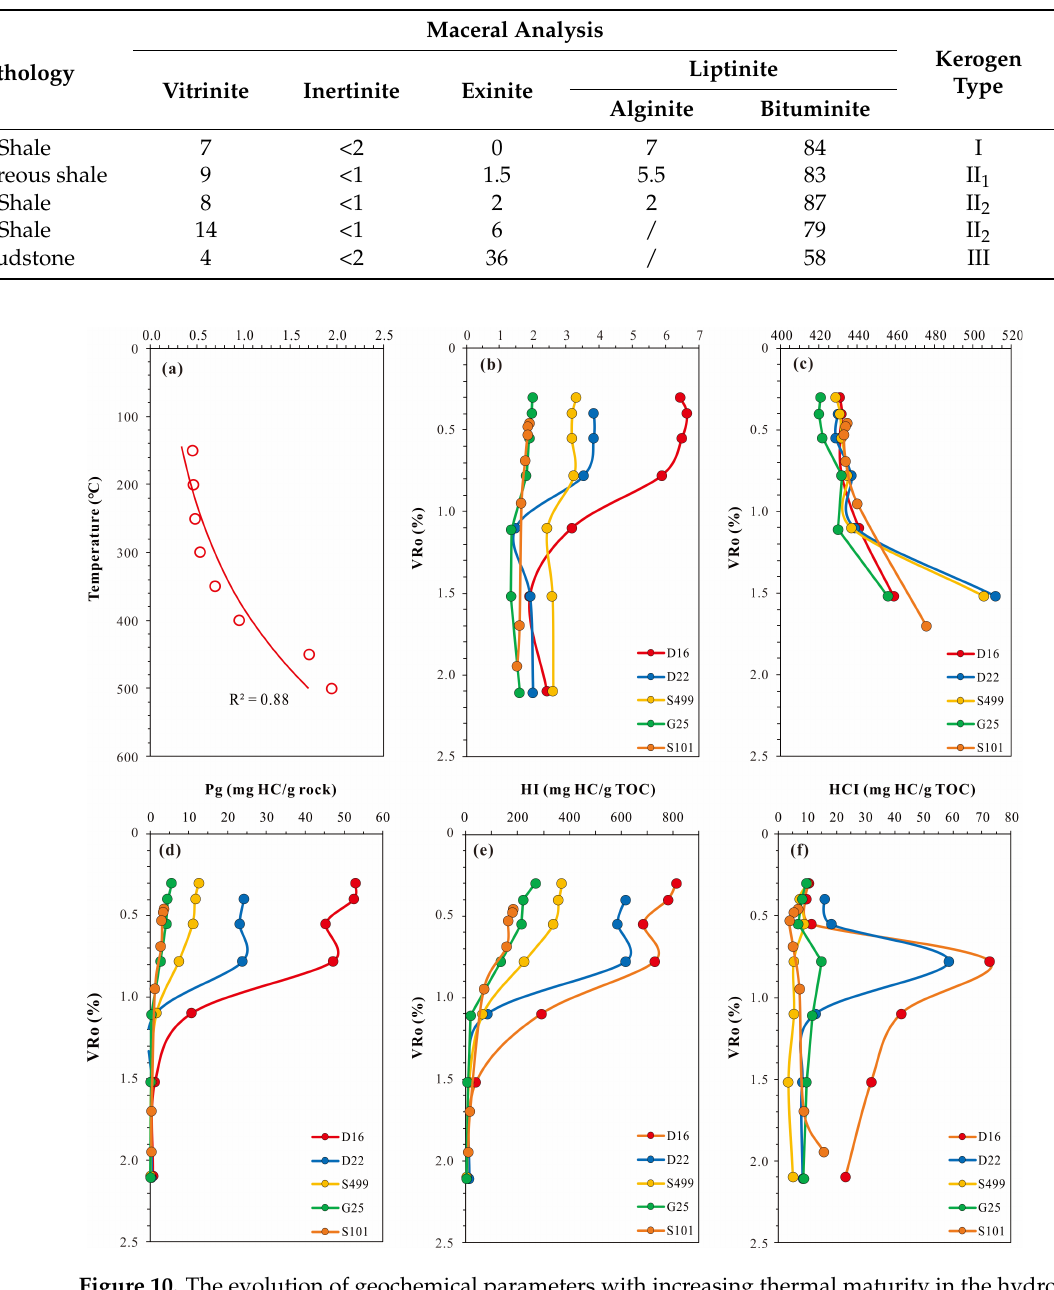
Figure 11. Variations in the hydrocarbon production rate with an increase in thermal maturity of the Es4 source rocks. ( a ) D16; ( b ) D22; ( c ) G25; ( d ) S499; ( e ) S101; ( f ) S101 (Parallel experiment).